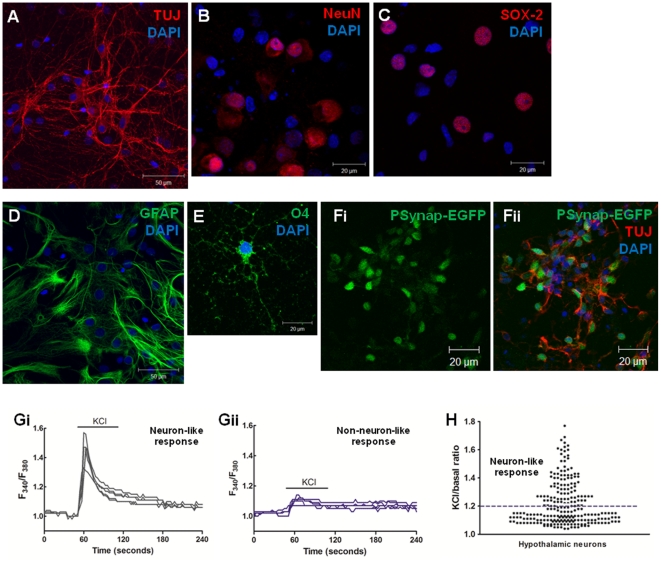
Hypothalamic neurospheres differentiate to mature functional neurons.Characterization of hypothalamic neurons culture obtained from plated neurospheres after 18 days in differentiation conditions. Differentiated hypothalamic cultures predominantly express neuronal marker TUJ (A) and mature neurons marker NeuN (B) but also multi-potency marker SOX-2 (C). Hypothalamic cultures also express astrocytes marker GFAP (D) and oligodendrocytes marker O4 (E). (F) Infection of hypothalamic neurons culture with AAV vectors expressing EGFP under the control of the synapsin neuronal specific promoter (Psynap), after 10 days of differentiation. (Fi) Neurons expressing the EGFP protein showing that the neuronal promoter is active and (Fii) merge image with neuronal marker TUJ. DAPI, nuclear staining. Representative recordings of intracellular calcium concentrations ([Ca2+]i) of hypothalamic cells with neuron-like response (Gi) or non-neuron-like response (Gii) to 50 mM KCl depolarization. (H) Distribution of hypothalamic cells according to the KCl/basal ratio obtained after a potassium stimulus. n = 3 independent culture preparations. AAV, adeno-associated virus; EGFP, enhanced green fluorescent protein.